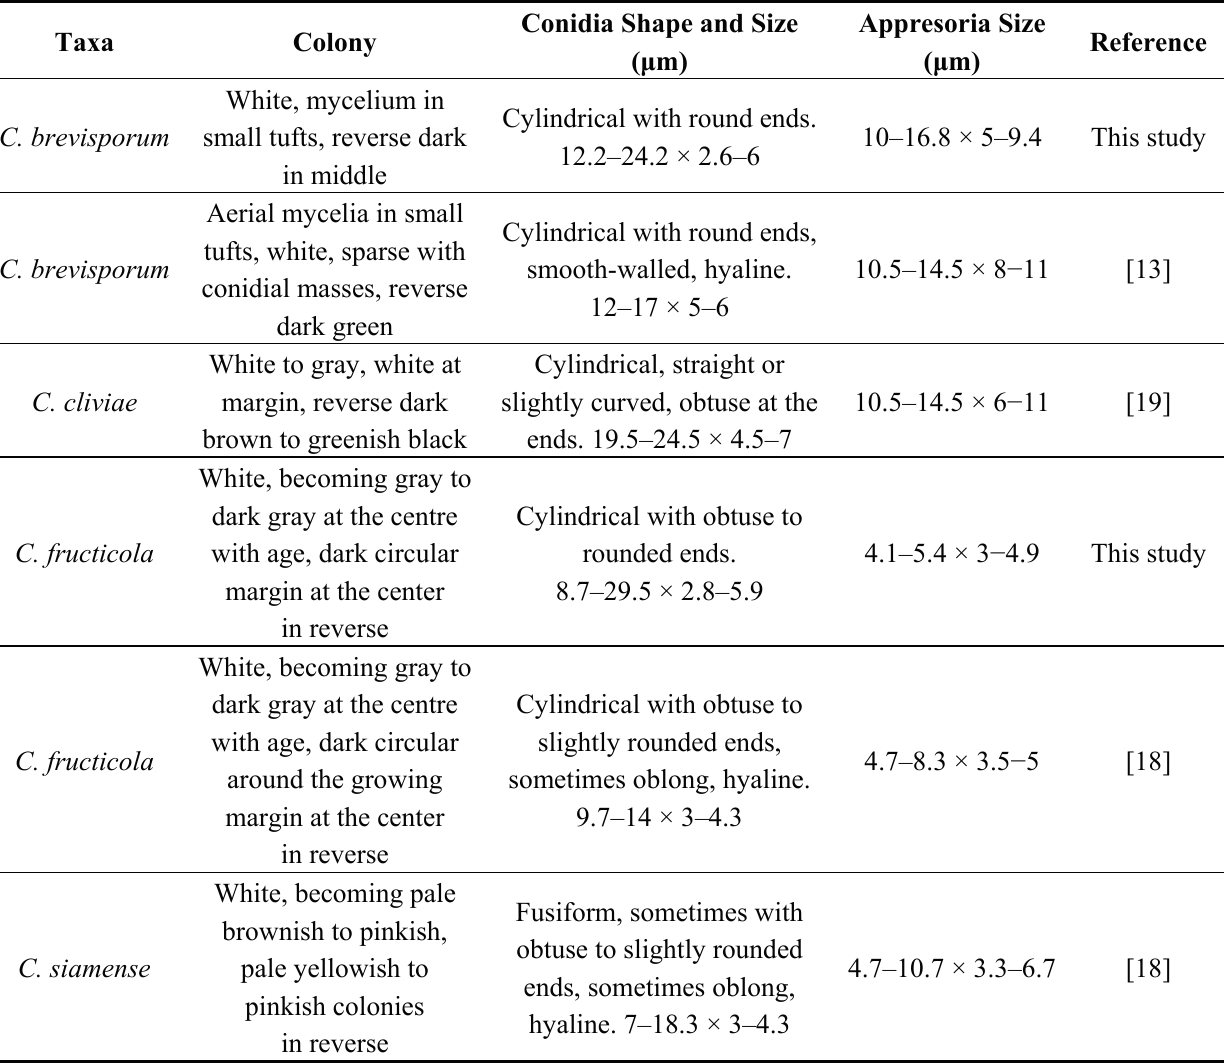
Table 2. Morphological characters of Colletotrichum species described in this study and closely related reference